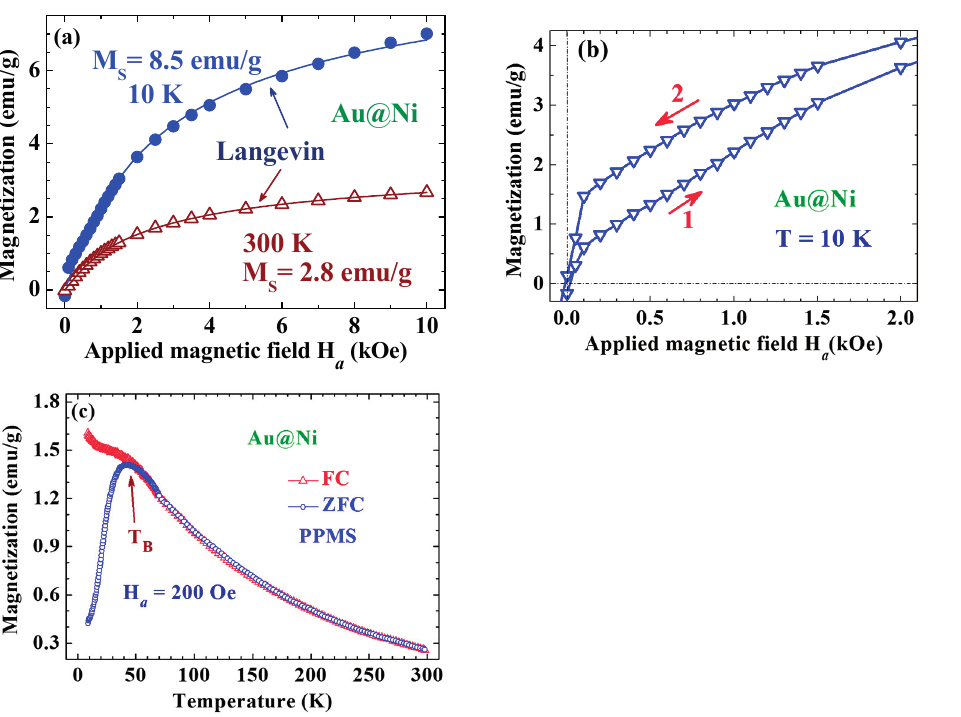
Figure 3. ( a ) M ( H a ) curves taken at two representative temperatures of 10 and 300 K, where the solid lines indicate the fits of the data to the Langevin profile; ( b ) M ( H a ) loops taken